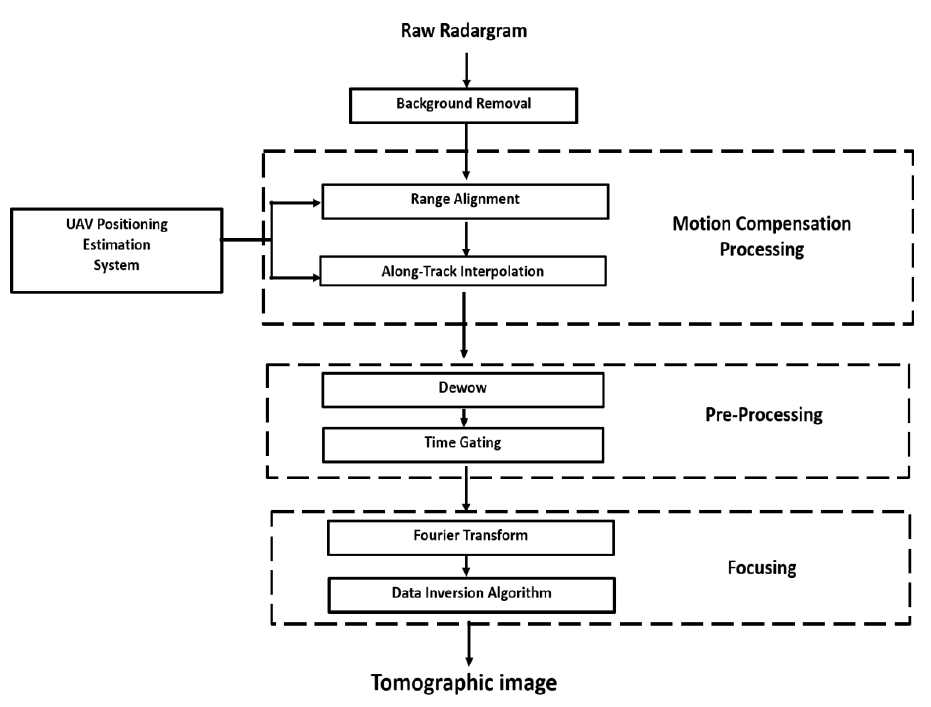
Figure 3. Signal Processing Strategy.